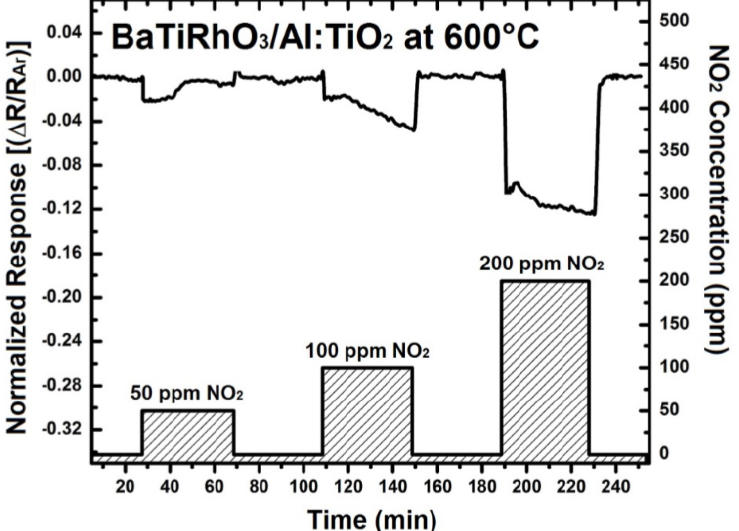
Figure 11. Sensor response of BaTi 0.95 Rh 0.05 O 3 catalytic + Al-doped TiO 2 sensor duplex layers at 600 °C toward NO in a dry synthetic air environment.